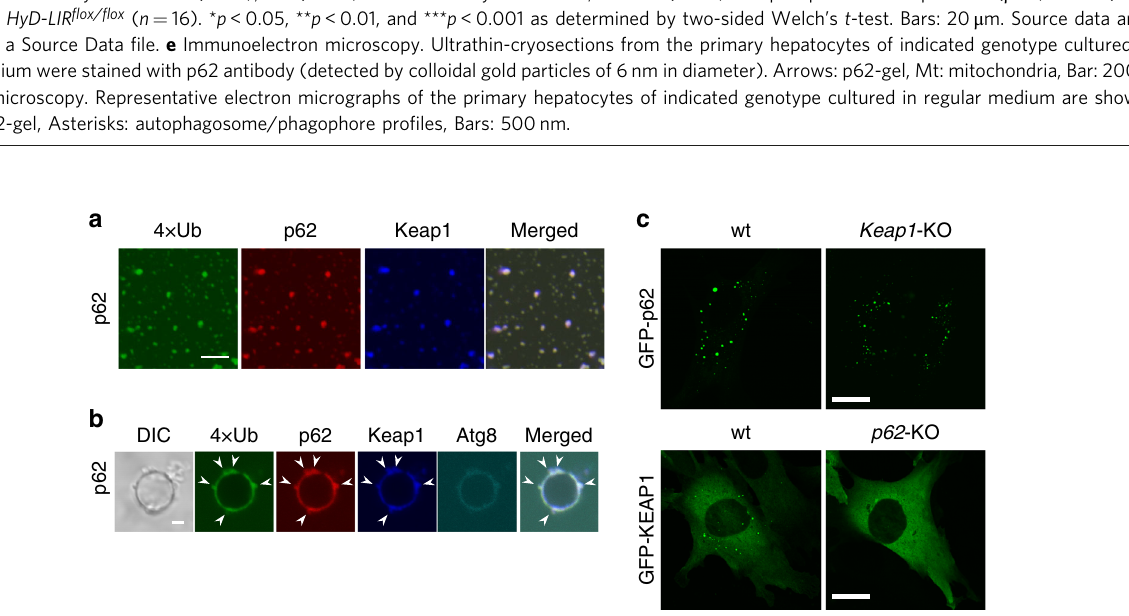
Fig. 4 The interaction of p62 with LC3 directs autophagosomes toward the p62-gel. a Model of the effect of HyD-LIR-Venus. b Immunoblot analysis. Primary hepatocytes isolated from indicated genotype mice were cultured in regular medium in the presence or absence of 100 nM Ba fi lomycin A 1 (Baf.) for 24 h or cultured in amino acid-deprived medium for 4 h (Stv.) in presence or absence of Baf. Cell lysates were prepared and subjected to immunoblot analysis with the indicated antibodies. Data shown are representative of three separate experiments. Bar graphs indicate the quantitative densitometric analysis of the indicated proteins relative to whole proteins estimated by Ponceau-S staining ( n = 3). Data are means± s.e. * P < 0.05 as determined by two- sided Welch ’ s t -test. Source data are provided as a Source Data fi le. c , d Immuno fl uorescence microscopy. Primary hepatocytes described in b were cultured in regular medium (Fed) ( c, d ) or amino acid-deprived medium for 4 h (Starved) ( c ). The cells were immunostained with indicated antibodies. The number of LC3- and p62-positive dots in hepatocyte was determined in each genotype. Data are means± s.e. of LC3-positive dots per area ( μ m 2 ) in fed ( n = 5) and starved HyD-LIR fl ox/ fl ox ( n = 5), fed ( n = 11) and starved HyD-LIR fl ox/ fl ox ; Alb- Cre ( n = 9) and p62-positive dots per area ( μ m 2 ) in fed ( n = 12) and starved HyD-LIR fl ox/ fl ox ( n = 16). * p < 0.05, ** p < 0.01, and *** p < 0.001 as determined by two-sided Welch ’ s t -test. Bars: 20 μ m. Source data are